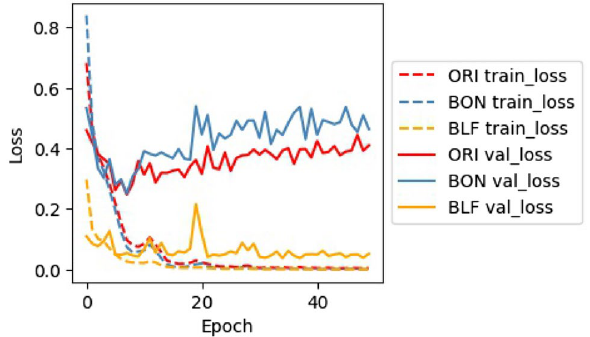
Figure 4. Loss of ORI, BON, and BLF models during training and on the validation dataset.